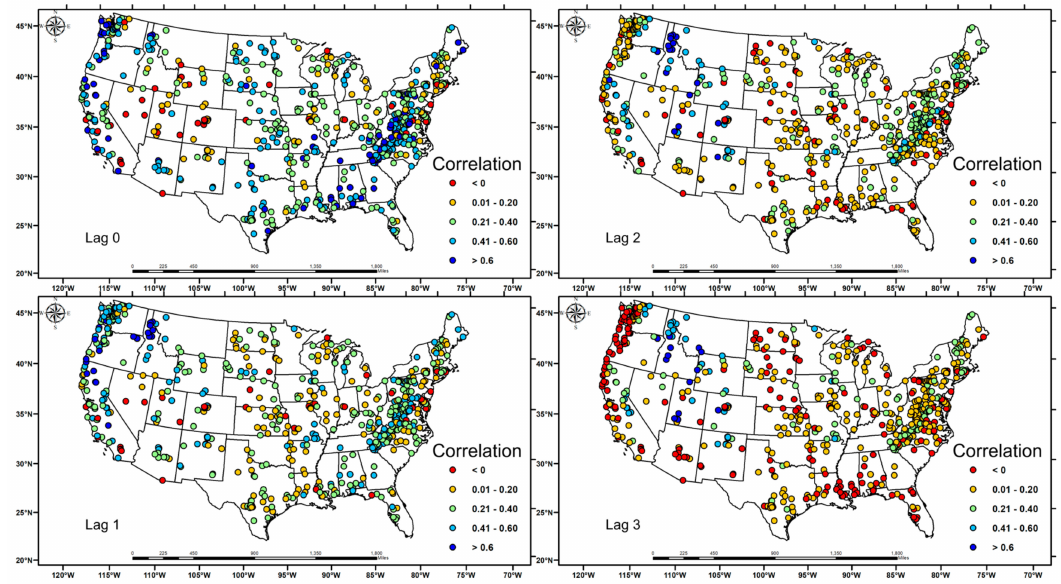
Figure 5. Spatial variation of correlation coe ffi cients of root-zone soil moisture for di ff erent lag months.